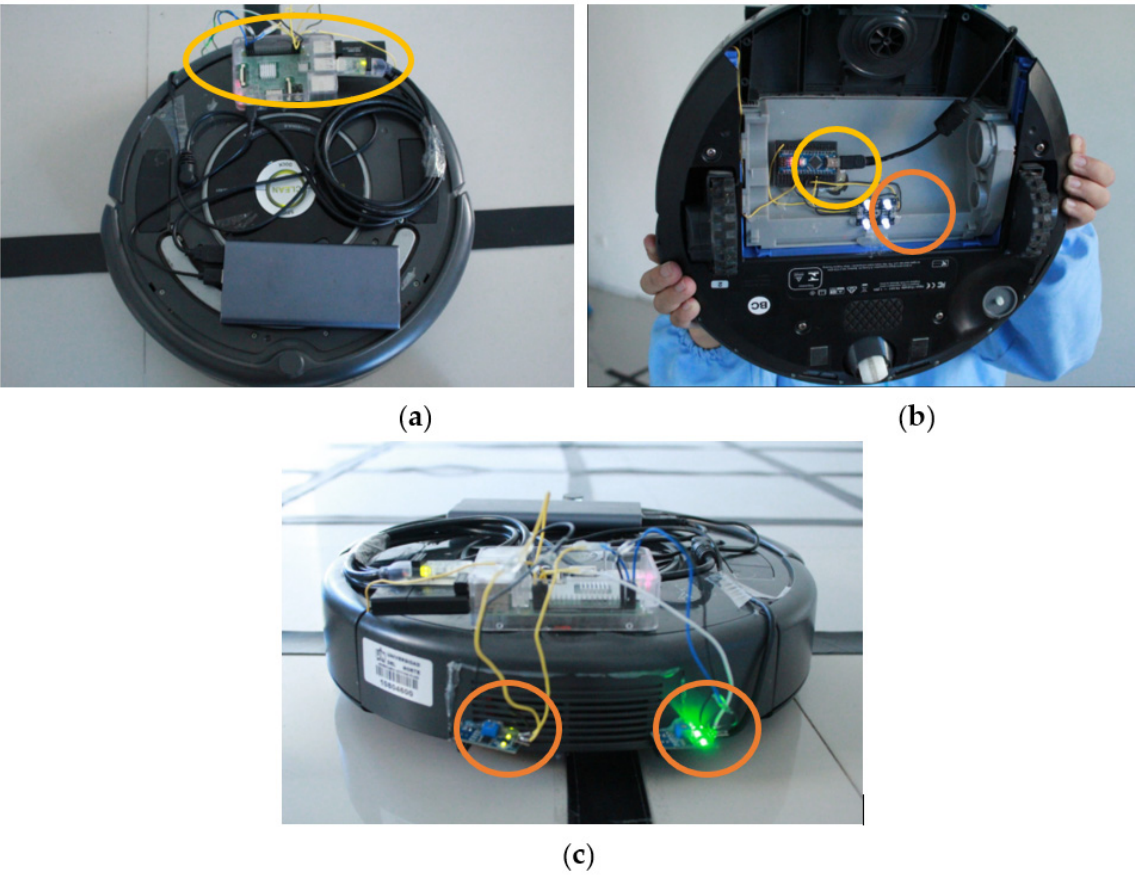
Figure 2. Robot’s hardware setup. ( a ) Raspberry Pi 3 added to the Create 2 Robot; ( b ) Color. sensor connected to the Arduino nano; ( c ) Two optical-reflective sensors.